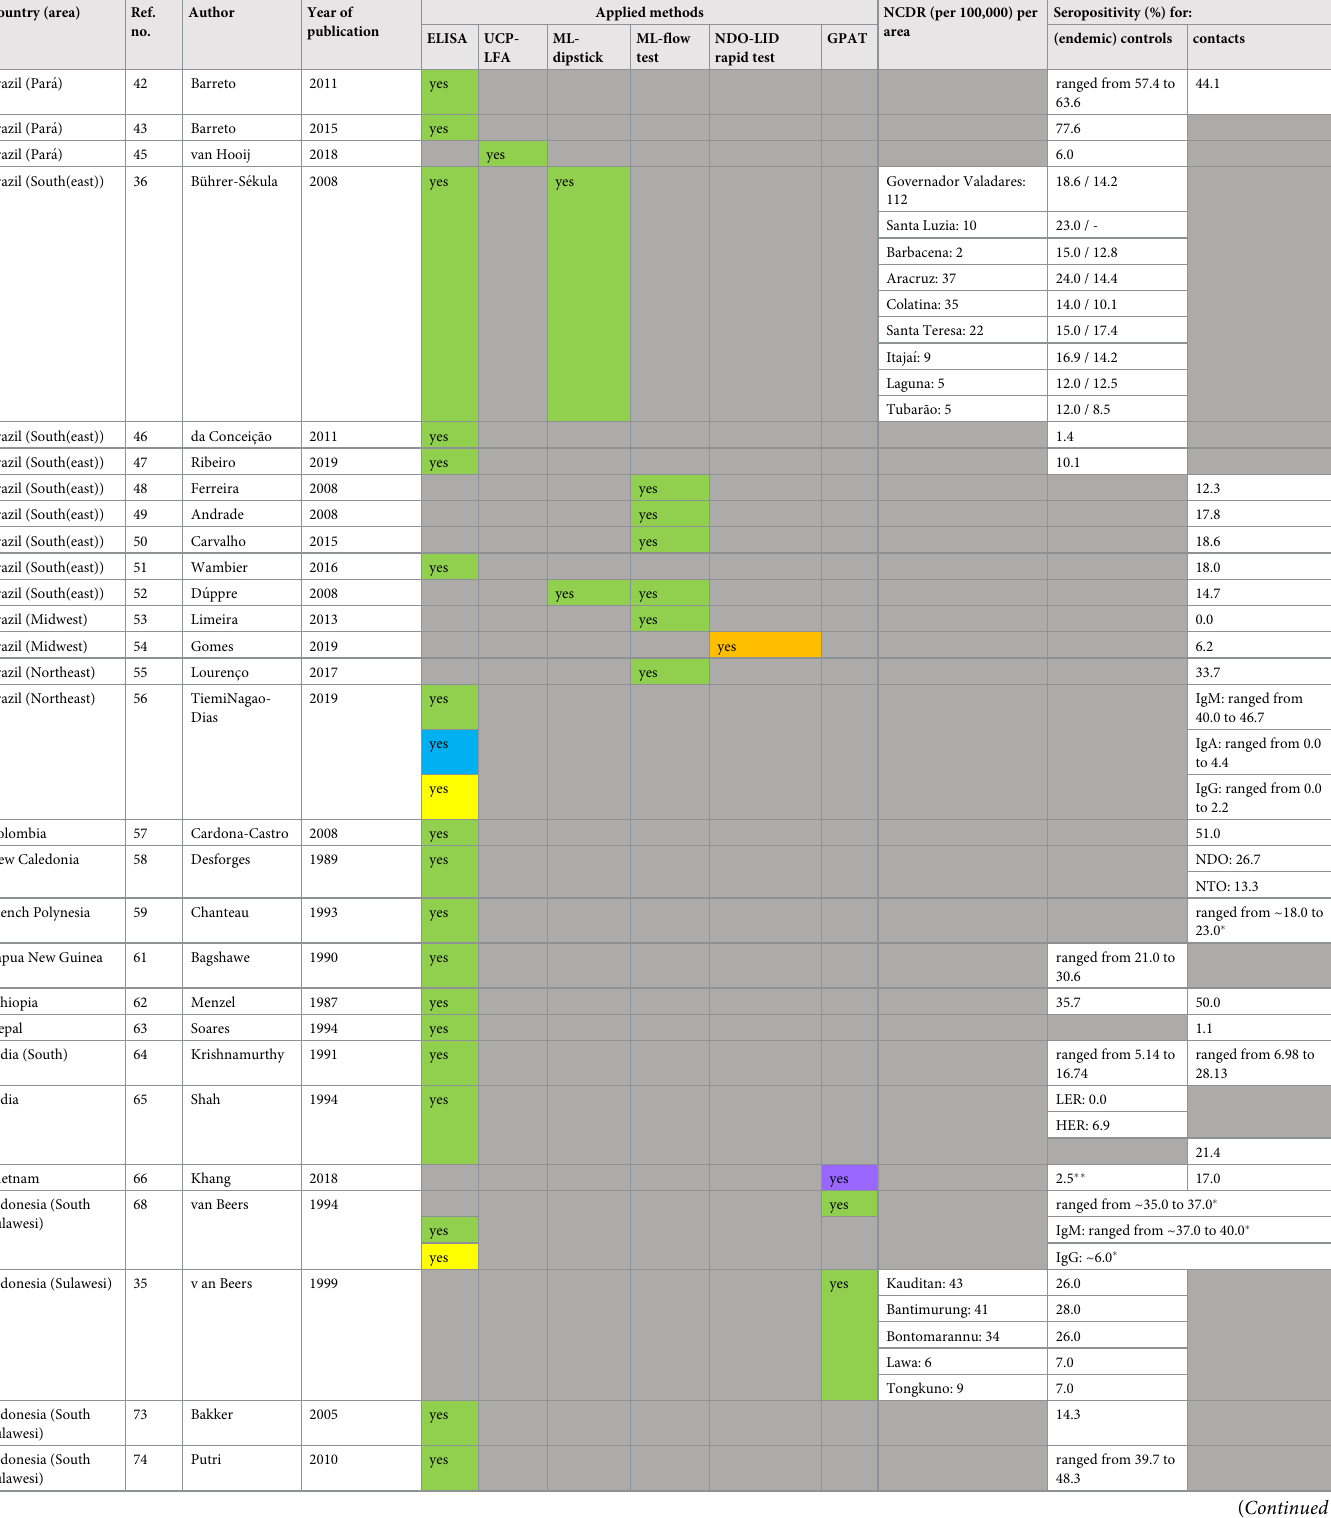
Table 3. Prevalence of seropositivity for M . leprae antibodies in children without leprosy sorted per country and test group. Country(area) Ref.